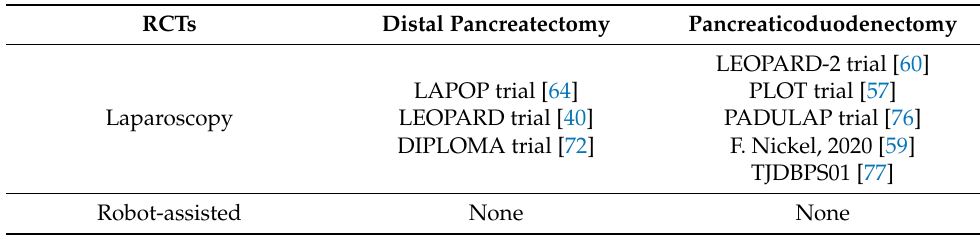
Table 4. Randomised-controlled trials (RCTs) which evaluate minimally invasive approach in pancre- atic surgery (not specific to